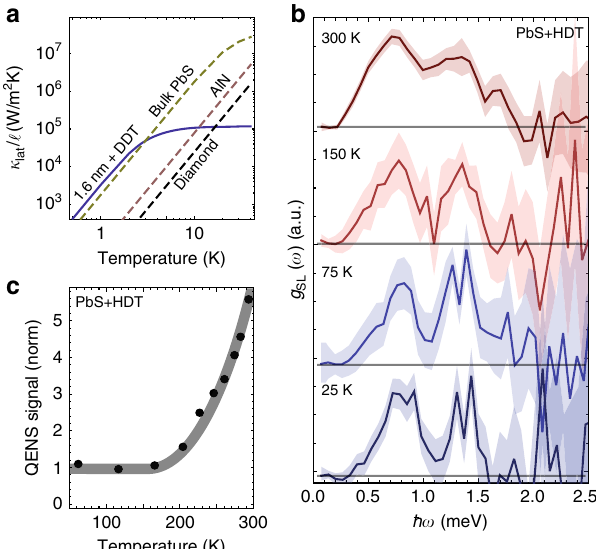
Fig. 4 Temperature Dependence of Nanocrystal Phonons.: a Temperature dependence of the lattice thermal conductivity normalized by phonon mean-free-path-length of 1.6 nm PbS NC + DDT superlattice, as well as bulk PbS, diamond, and aluminum-nitride. b Extracted g SL ( ω ) at 300 K, 150 K, 75 K, and 25 K for a NC superlattice fabricated with 1.6 nm NCs and HDT ligands. c Quasi-Elastic-Neutron-Scattering (QENS) intensity integrated from 20 to 50 μ eV for the 1.6 nm NCs and HDT